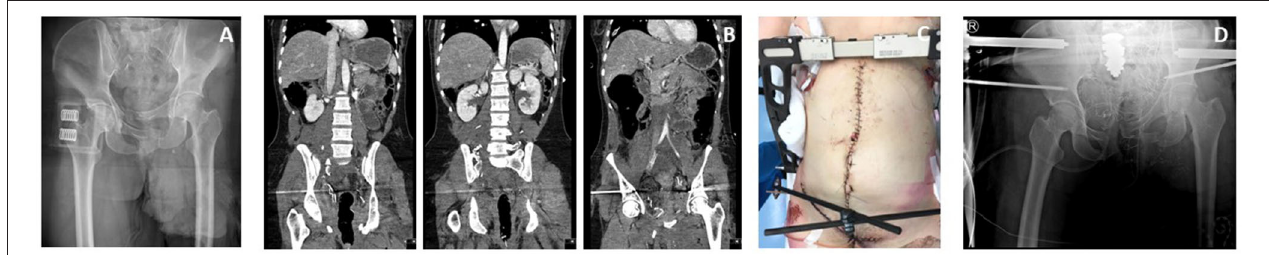
FIGURE 3 | Case of a patient in which a pelvic binder was used in the ED to temporarily stabilize the pelvis (A) . After initial surgical stabilization with a supracetabular external fixator and pelvic packing a CT scan was made showing additional injury to the posterior side of the pelvic ring (B) . Because of persisting posterior mechanical instability a C-clamp was also used to further reduce the pelvis (C,D) and allow for better control of the pelvic